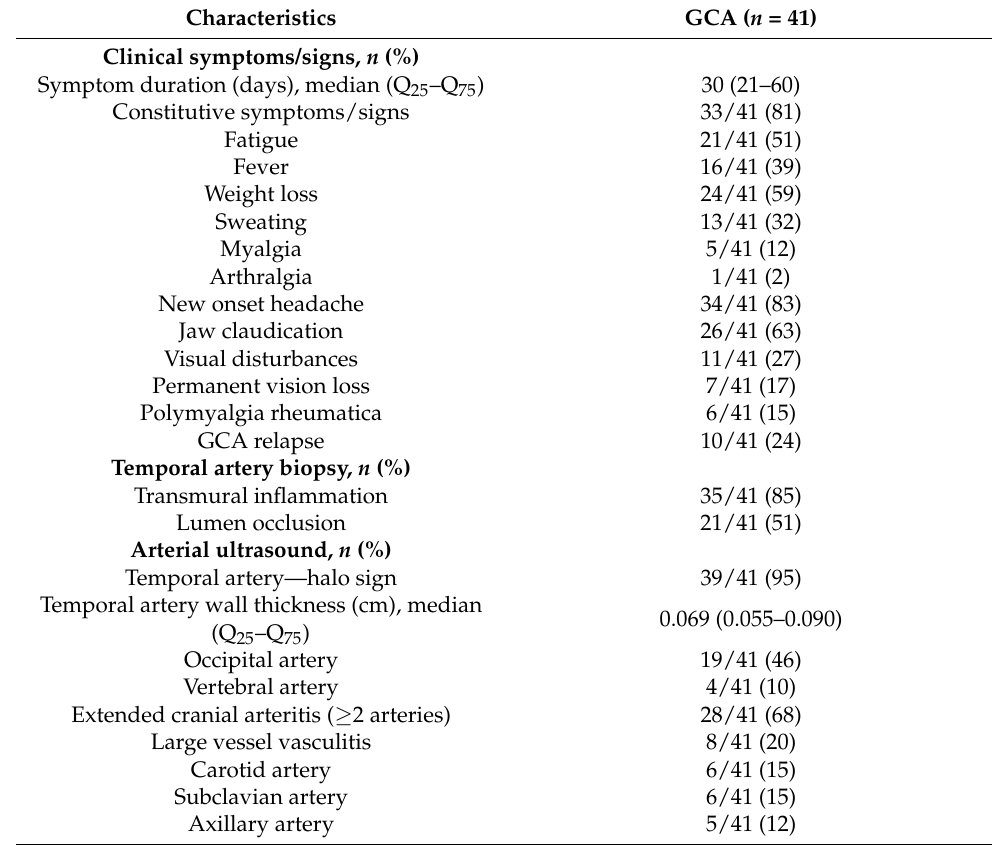
Table 1. Clinical and laboratory characteristics of GCA